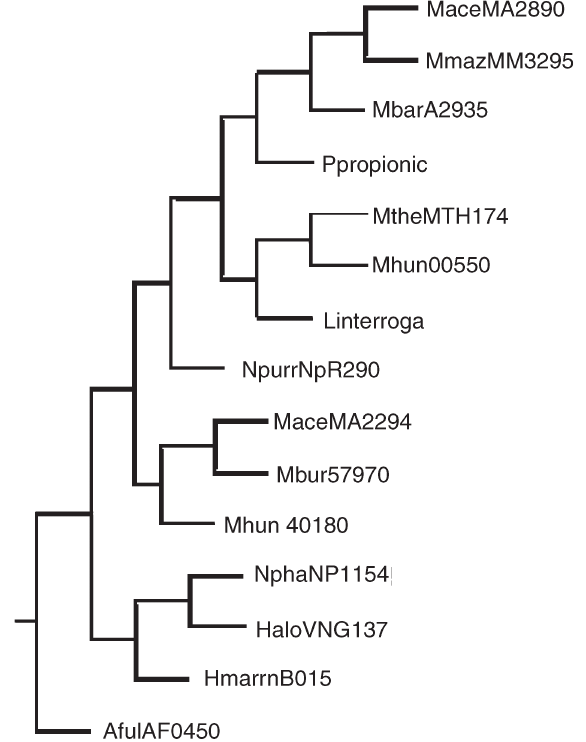
Figure A1. Phylogenetic analysis by neighbor-joining of putative two-component open reading frames (ORFs) from histidine kinase II groups ahk5 and ahk22 . Group ahk5 = MaceMA2890, MbarA_2935, MmazMM3295, MtheMTH174 and Mhun_401800550; and group ahk22 = MaceMA2294, Mbur_401657970, HaloVNG1374G, Mhun_401803800, AfulAF0450, NphaNP1154A and HmarrnB0156. The bacterial ORFs are Ppropionicus, NpunNpR2903 and Linter- rogans. Abbreviations: Ppropionicus = P. propionicus _500413890; NpunNpR2903 = N. punctiforme ; and Linterrogans = L. interrogans- LA2540.